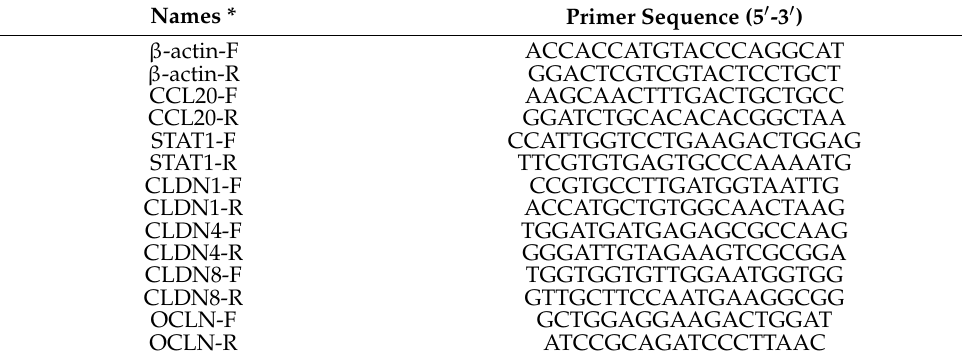
Table 1. List of primers used in this study. Names * Primer Sequence (5 (cid:48) -3 (cid:48)